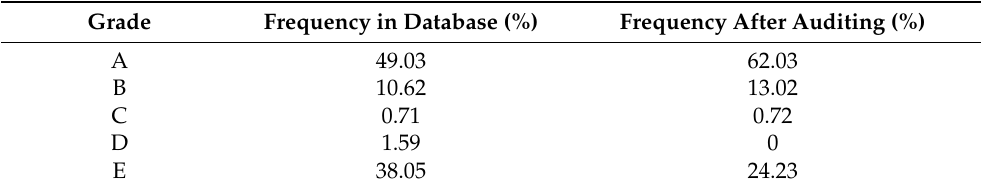
Table 2. Summary results of Felidae dataset downloaded from BOLD on 17 November